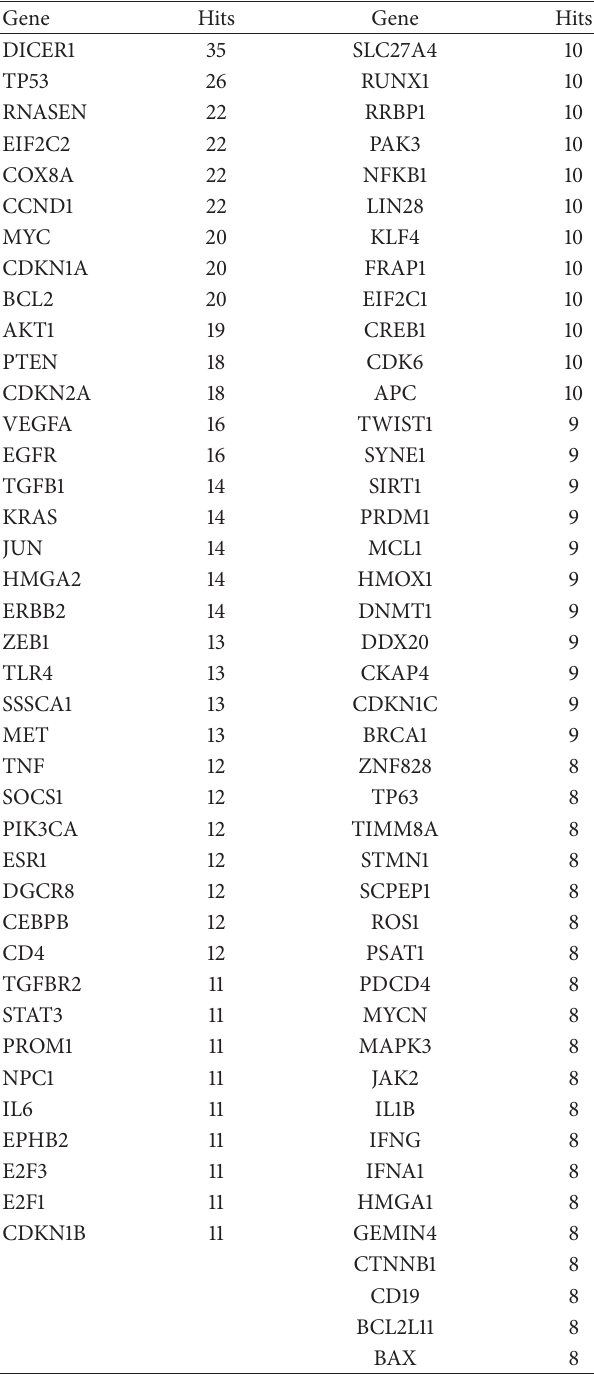
Table 2: ceRNA organized in hierarchical order for the number of validated microRNA